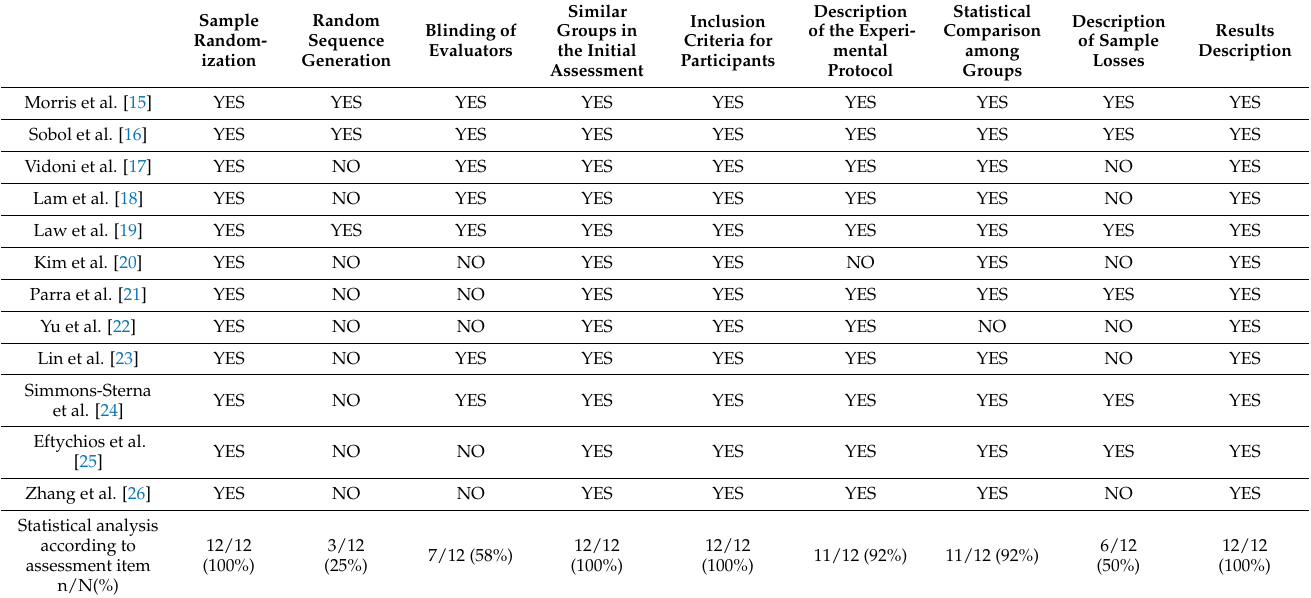
Table 3. Evaluation of the methodological quality of the studies